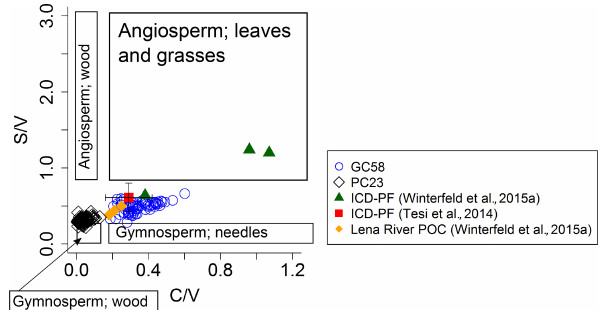
Figure 6. Lignin composition of the sediment core GC58 (blue cir- cles). The ratio between cinnamyl and vanillyl phenols (C / V) is used as a proxy to distinguish between soft and woody plant tis- sues. The ratio of syringyl to vanillyl phenols (S / V) indicates the difference between gymnosperm and angiosperm plants. The boxes indicate the typical values for S / V and C / V ratios characteris- ing different plant material (ranges from Goñi and Montgomery, 2000). Measured S / V and C / V ratios for Ice Complex deposit permafrost (ICD-PF) are shown with green triangles (Winterfeld et al., 2015) and with a red square ( ± standard deviation; Tesi et al., 2014). Measured S / V and C / V ratios for topsoil-PF (Lena River POC) are illustrated with orange diamonds (Winterfeld et al., 2015). Also shown is the lignin composition of the sediment core PC23 (black diamonds) from the Laptev Sea (study by Tesi et al.,